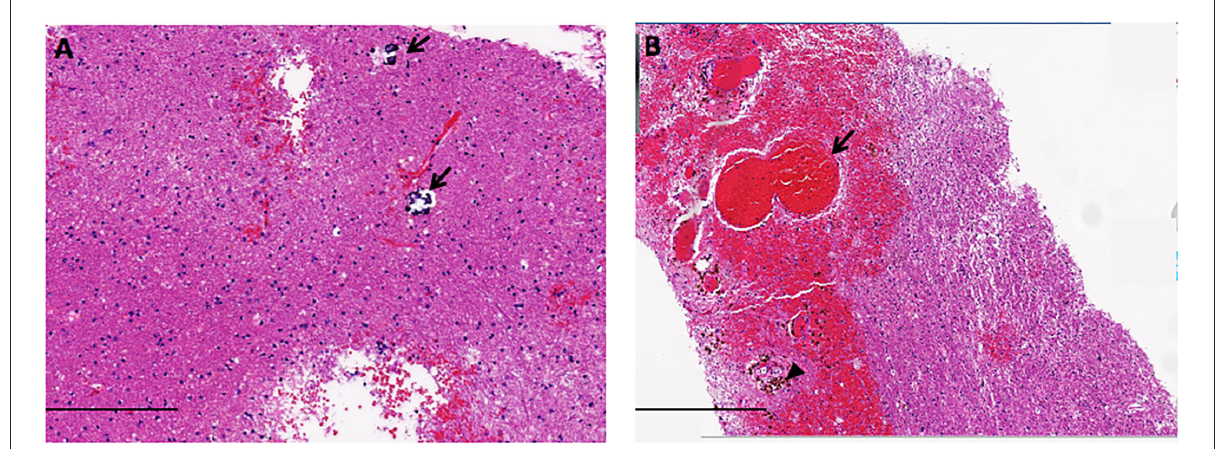
FIGURE2 The neuropathology of LS showed small calcification scattered [arrow in (A) ], atypical gliosis, hemorrhage [arrow in (B) ], and hemosiderin deposition [arrowhead in (B) ], in the white matter (scale bars A = 200 µ m, B = 400 µ